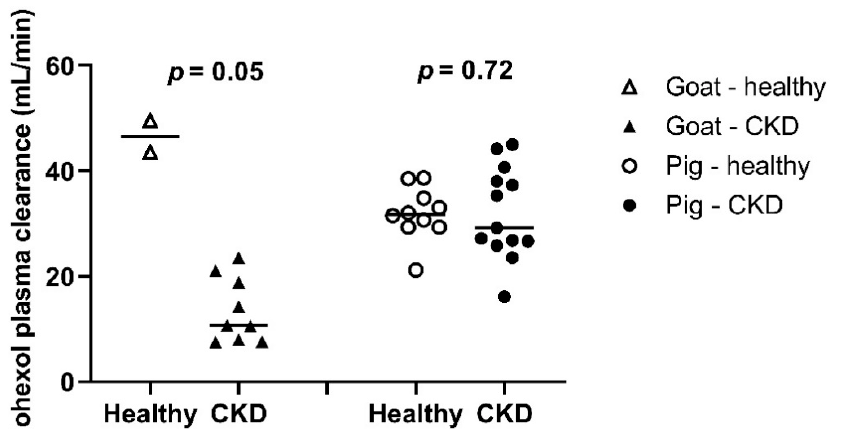
Figure 2. Iohexol plasma clearances after bolus administration of iohexol in goats and pigs (3–8 months of age) before and after induction of CKD within the same animal (2 measurements in n = 2 goats and 10 measurements in n = 4 pigs before induction of CKD, and 11 measurements in n = 3 goats and 13 measurements in n = 5 pigs afterwards). p values were calculated using a Student’s paired t-test.